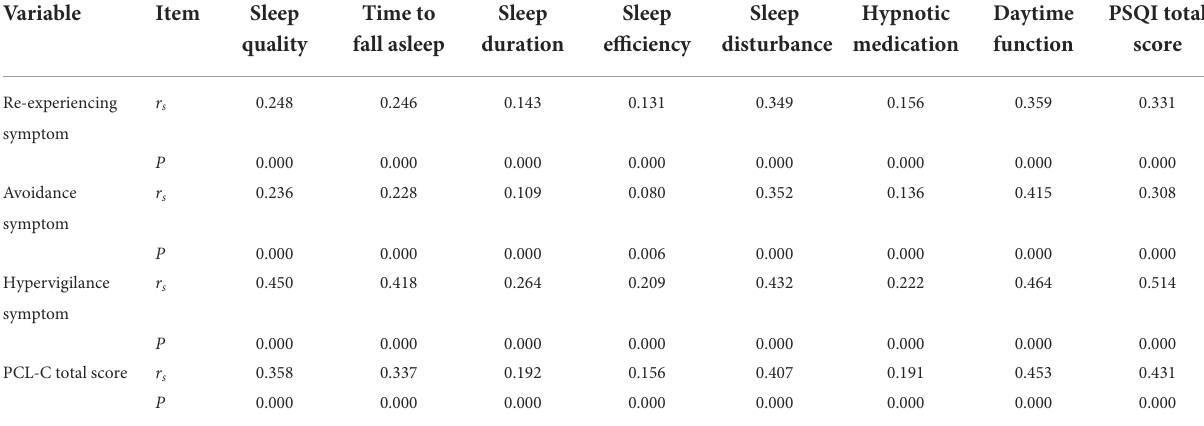
Daytime PSQI total function score